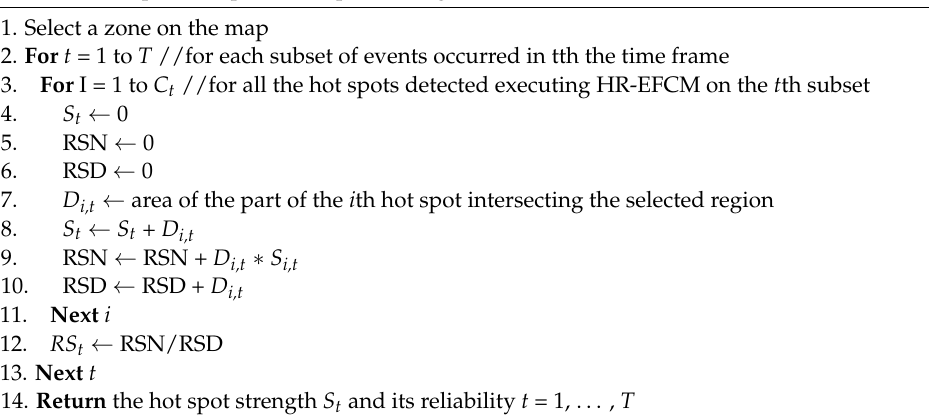
Algorithm 3 Spatiotemporal hot spots Strength Evaluation